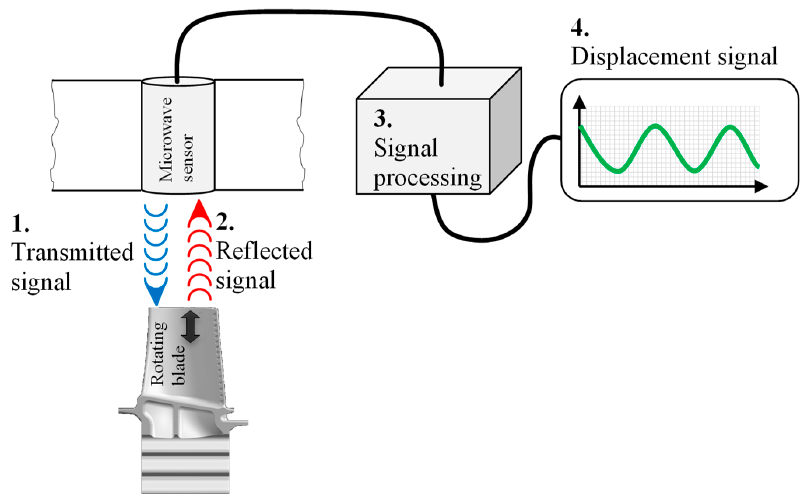
Figure 9 . Microwave tip timing system. Figure 9. Microwave tip timing